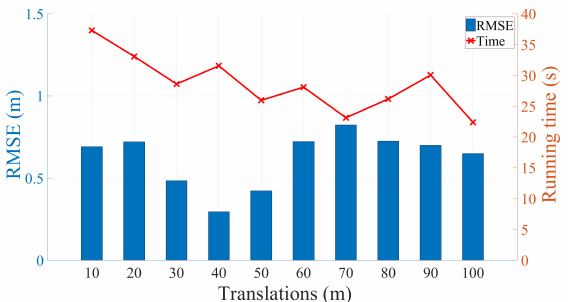
Figure 6. RMSE and running time of the test using Bremen dataset with different shifts.